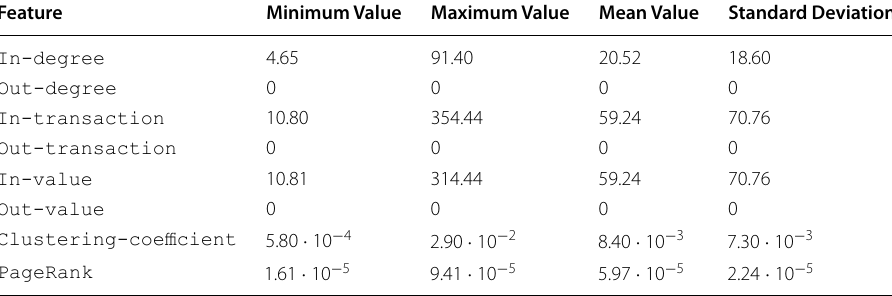
Table 4 Minimum, maximum, mean and standard deviation of the values of the spectrum features for the class “Token